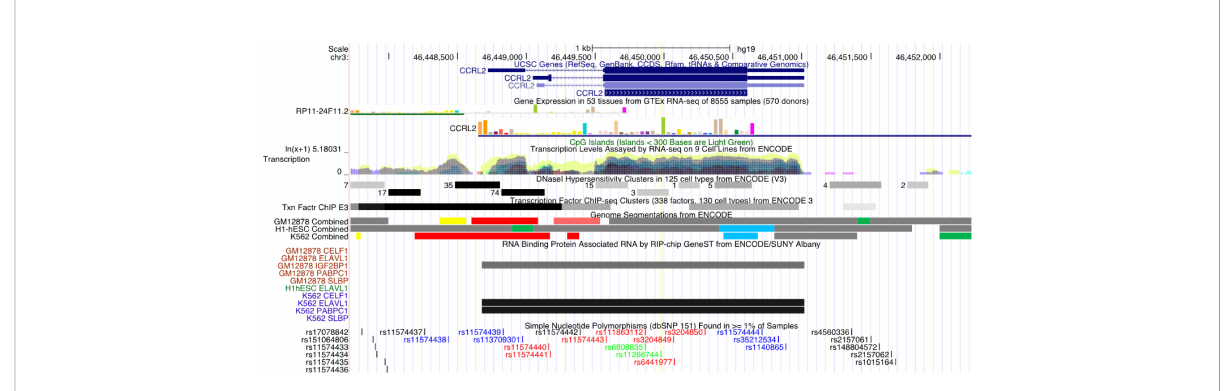
FIGURE 4 The regional association map of the rs11266744 locus. The SNP rs11266744 was located in the CCRL2 protein-coding region. This region showed very high conservation, transcription level and DNase I hypersensitivity.